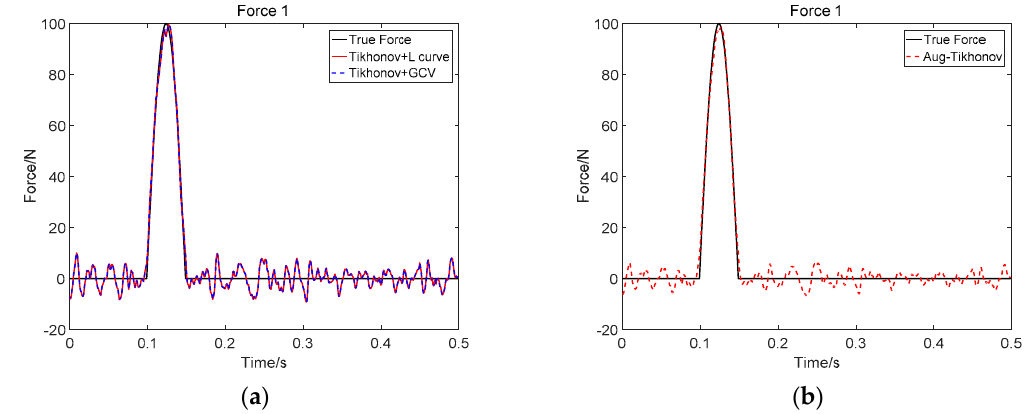
( b ) Figure 19. Identification result of two impact loads at SNR 40 dB (Force 2): ( a ) Tikhonov method; ( b ) the proposed method. ( a ) ( b ) Figure 20. Identification result of two impact loads at SNR 30 dB (Force 1): ( a ) Tikhonov method; ( b ) the proposed method.